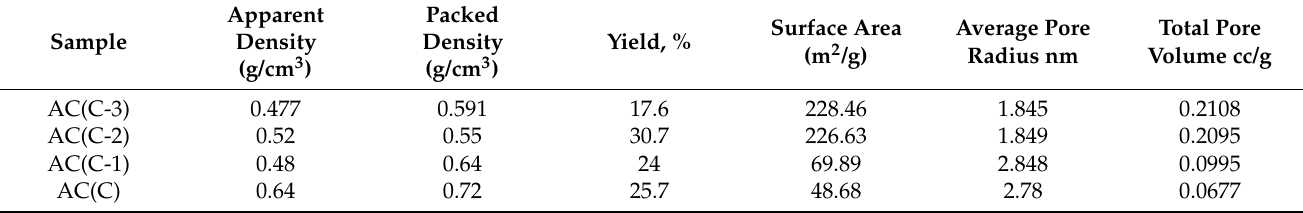
Table 3. The physical properties of the selected prepared activated carbon